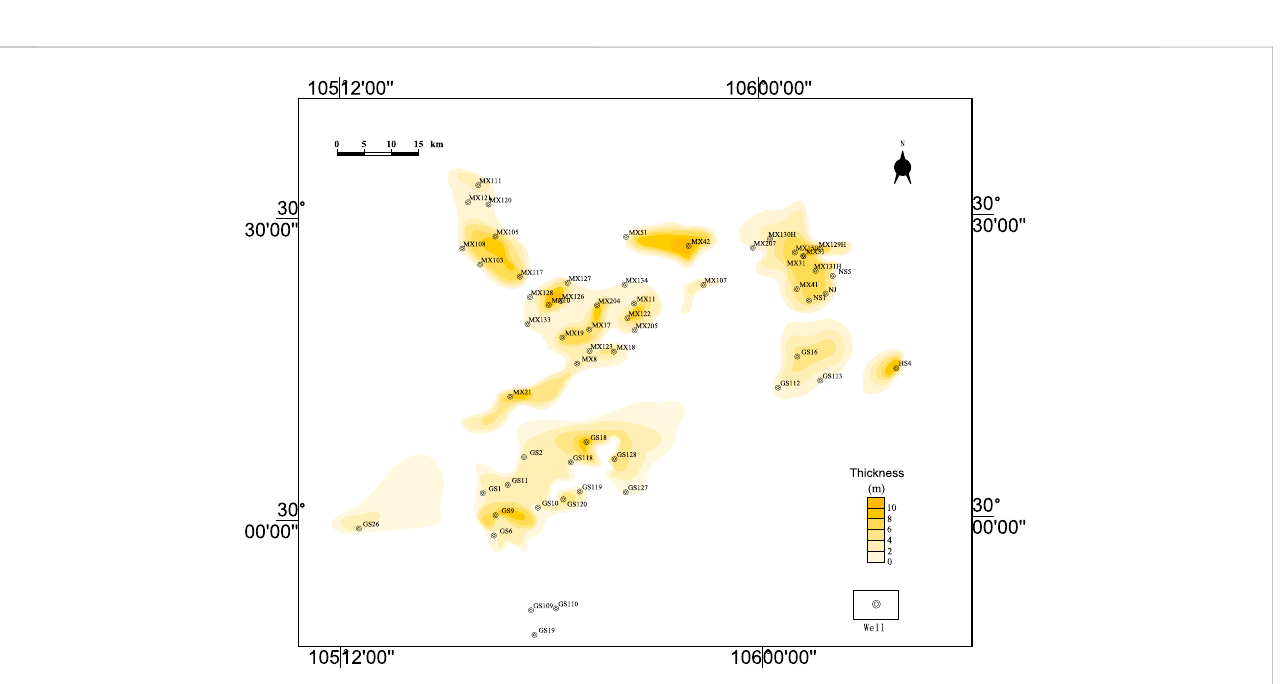
FIGURE 11 Thickness distribution of dolomite reservoirs of Permian Qixia Formation in central Sichuan